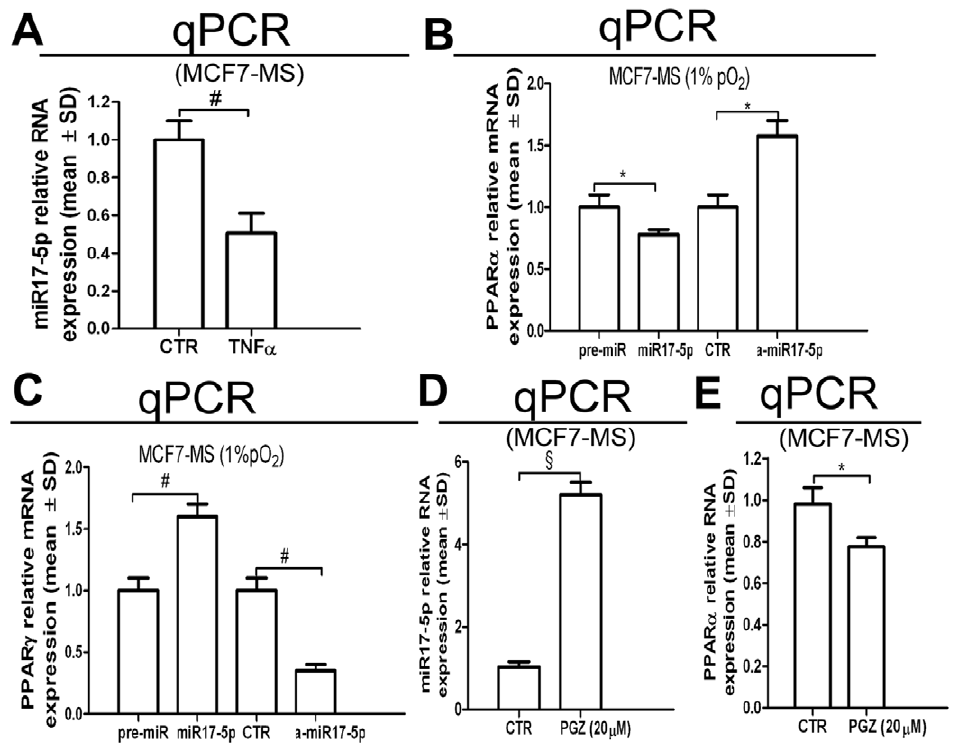
Figure 5. Role of miR17-5p on the PPAR a /PPAR c interplay in breast CSCs. (A) miR17-5p qPCR analysis in TNF a (0.75 ng/mL, 24 h)-exposed MCF7-MS. PPAR a mRNA (B) and PPAR c mRNA (C) qPCR analysis in pre-miR17-5p or antago-miR17-5p (a-miR17-5p)-transfected MCF7-MS (48 h). miR17-5p (D) and PPAR a mRNA (E) qPCR analysis in PGZ (20 m M, 24 h)-exposed MCF7-MS. Data are expressed as mean 6 S.D., n=3, * p , 0.05, # p , 0.01, 1 p , 0.005, ANOVA test. n.s.: not significant.